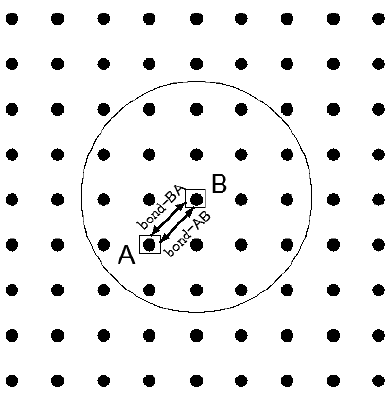
Figure 2. The interaction of parallel bonds between the material points A and B.